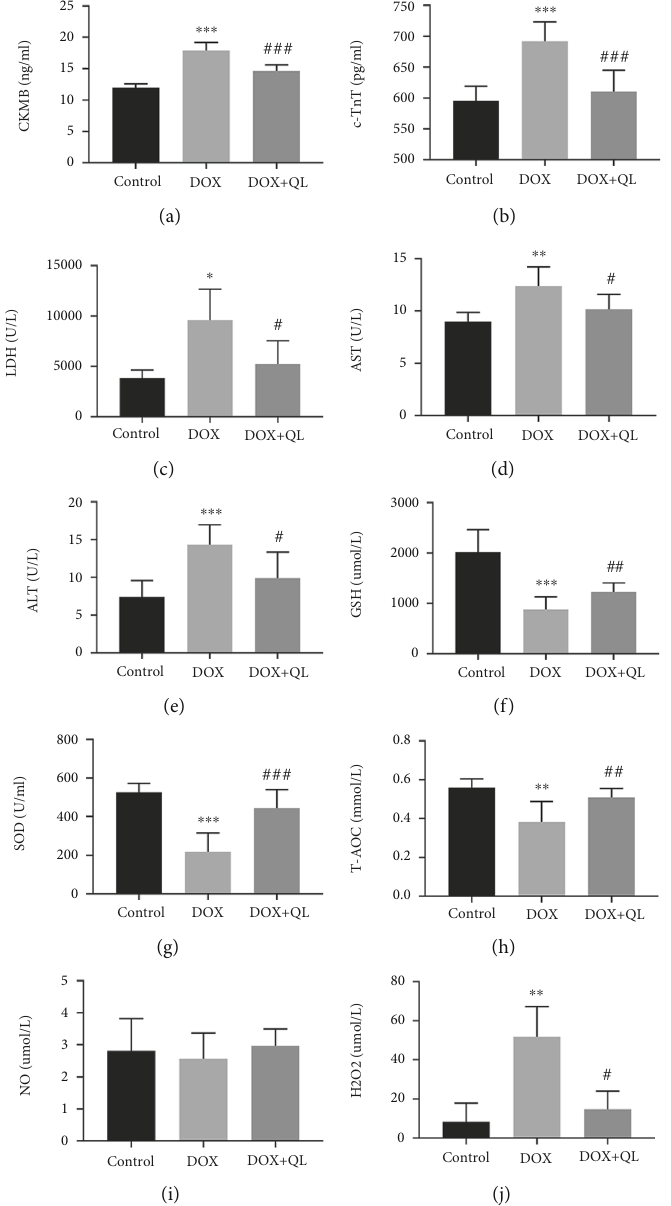
Figure 4: QL attenuated cardiac injury and oxidative stress in circulation in DOX-treated rats after DOX treatment for 28 days. (a – e) The concentrations of cardiac injury parameters in plasm. (f – j) The concentrations of oxidative stress-related molecules in plasm in three di ff erent groups (values are presented as mean ± SD ; ∗ P < 0 : 05 , ∗∗ P < 0 : 01 , and ∗∗∗ P < 0 : 001 vs. control group; # P < 0 : 05 , ## P < 0 : 01 , and ### P < 0 : 001 vs. DOX group; n = 10 per group). CKMB: creatine kinase isoenzyme-MB; c-TnT: cardiac troponin T; LDH: lactate dehydrogenase; AST: aspartate aminotransferase; ALT: alanine aminotransferase; GSH: reduced glutathione; SOD: serum superoxide dismutase; T-AOC: total antioxidant capacity; NO: nitric oxide; H O : hydrogen 2 2